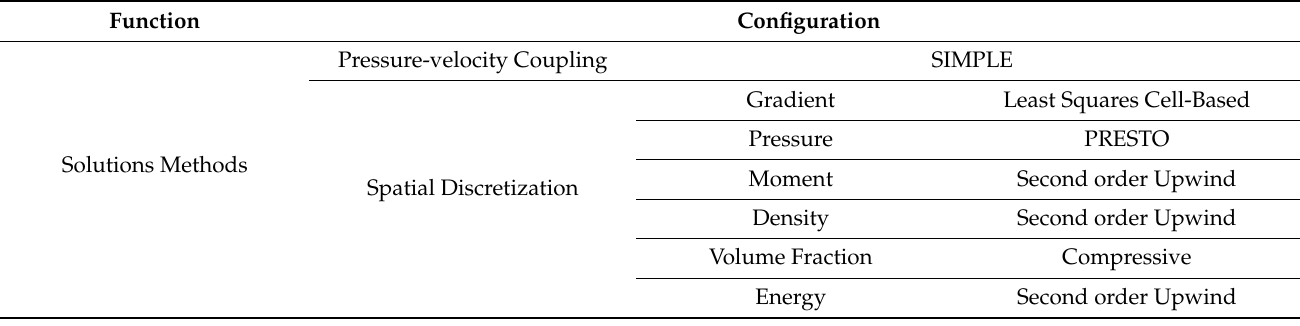
Table 8. Solution parameters used in CFD